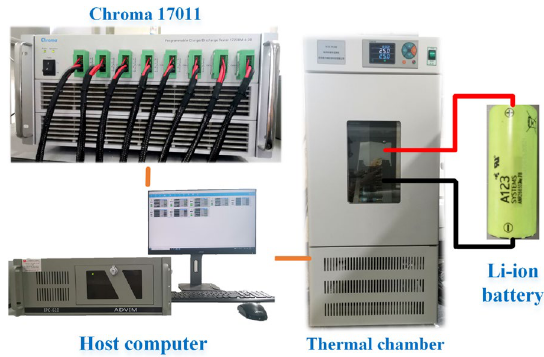
Figure 8 Experimental platform for the battery